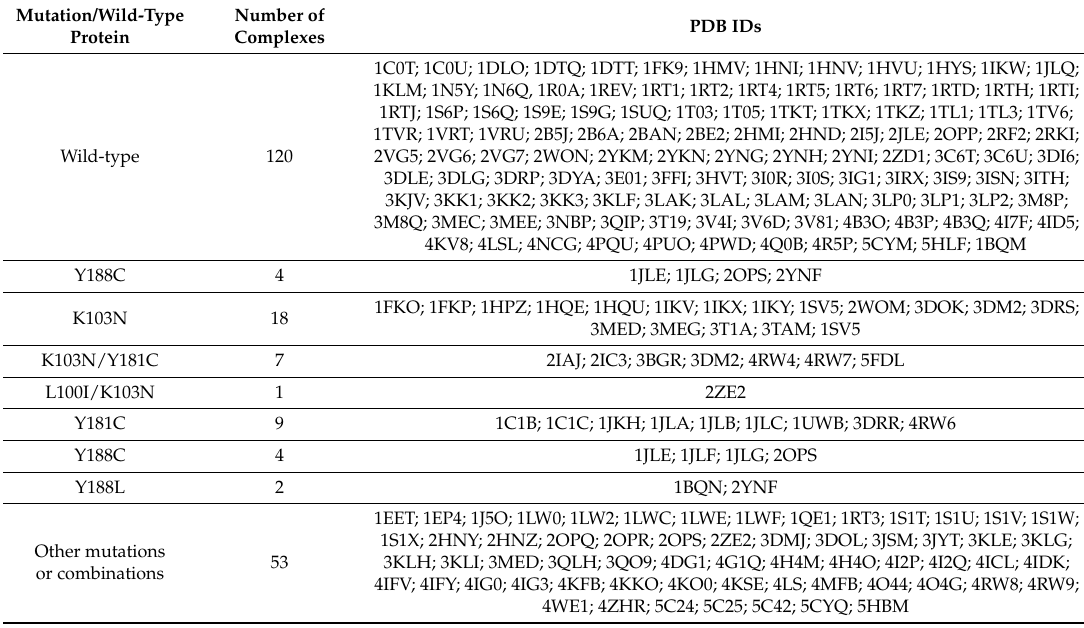
Table 2. Complexes of both wild-type and mutant HIV-1 reverse transcriptase with various inhibitors in Brookhaven Protein Data Bank (PDB) identification